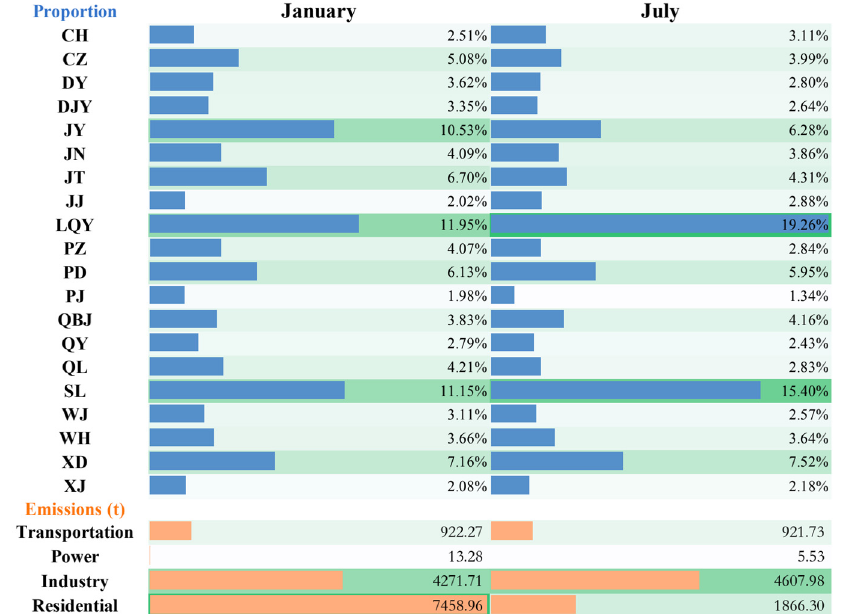
Figure 8. The proportion of PM 2.5 emissions in Chengdu and the emissions by sectors; blue represents the ranking of PM 2.5 emissions, orange represents the ranking of PM 2.5 emissions by sector, and green is the background color changing with the ranking.